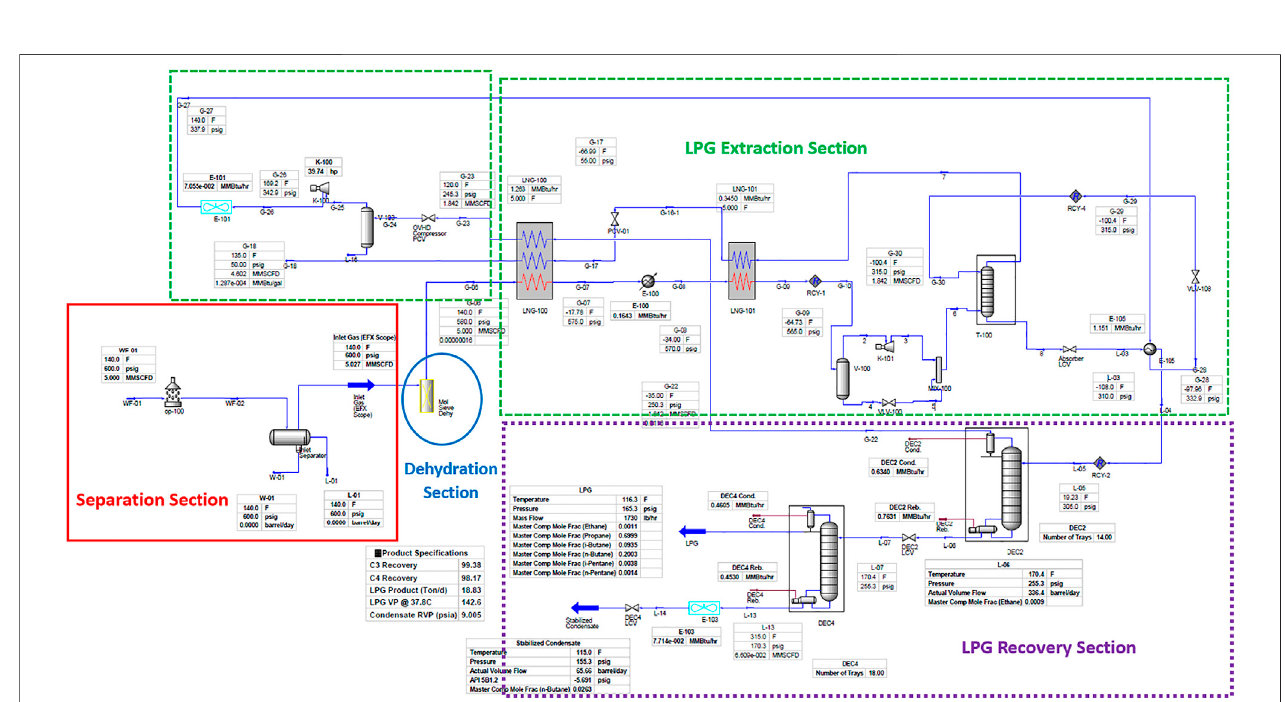
FIGURE 2 | Process fl ow diagram and Aspen HYSYS simulated case study for the LPG production from natural gas.